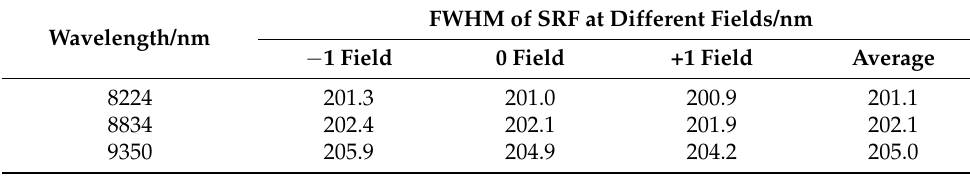
Table 7. Spectral resolution of B5 spectrometer with 3 × pixels